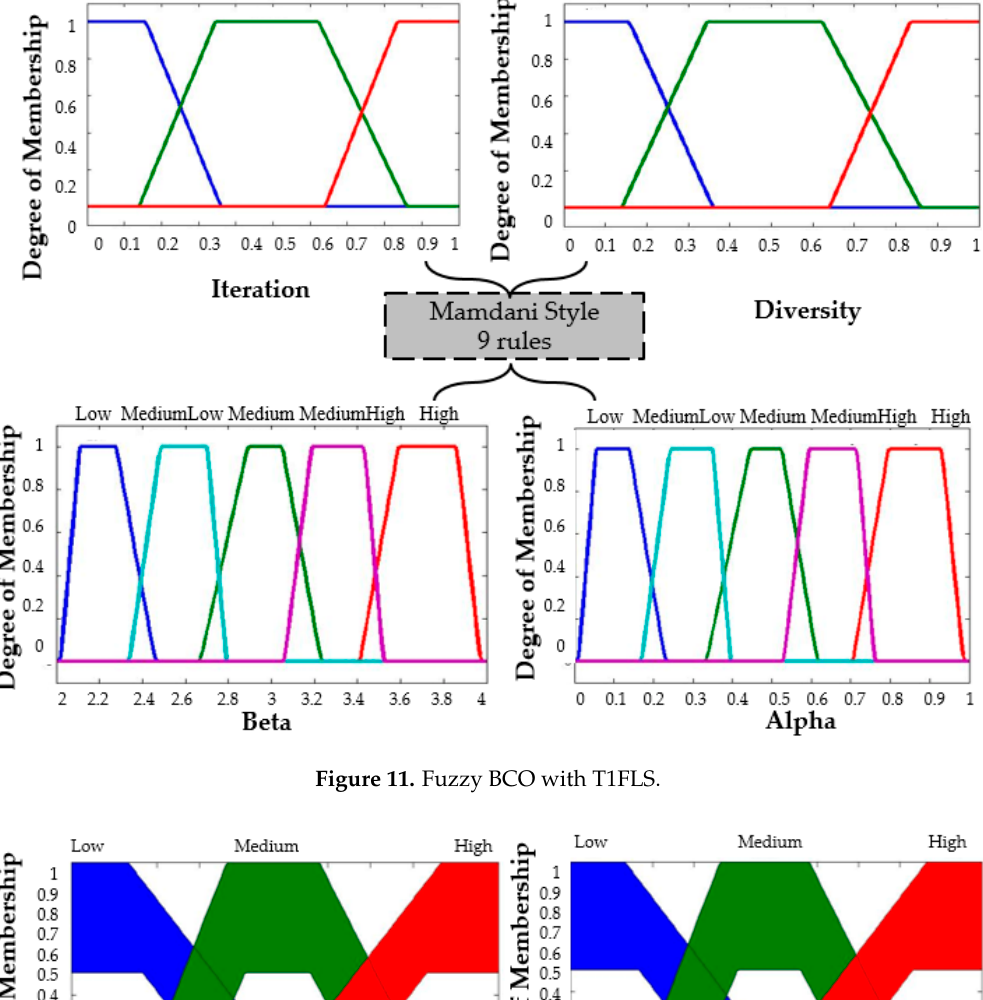
Figure 11. Fuzzy BCO with T1FLS.